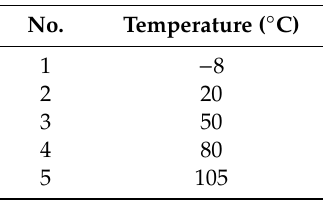
Table 2. Temperature condition in environmental